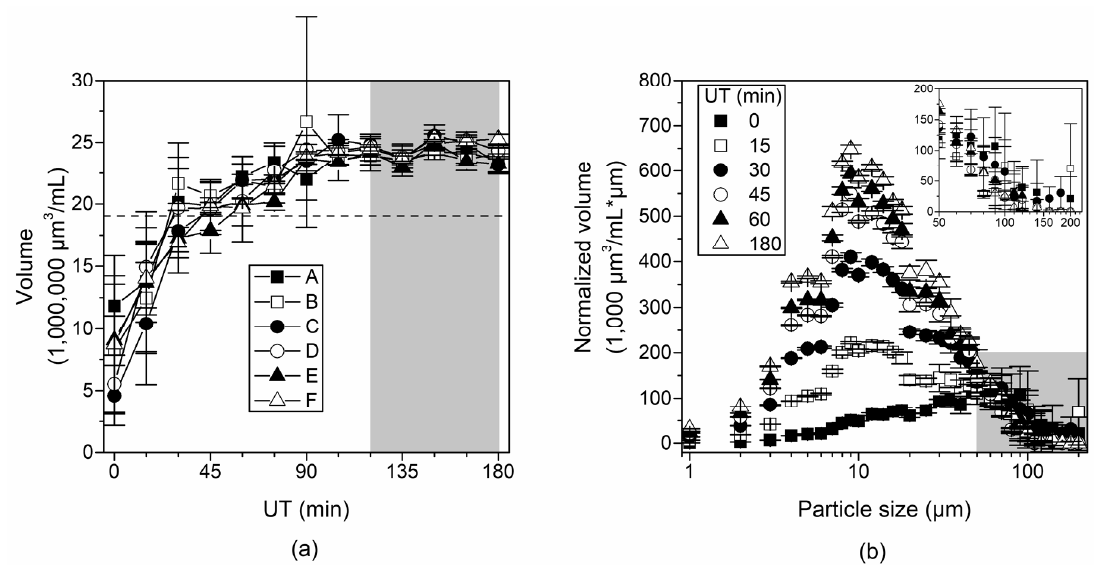
Figure 5. ( a ) Calculated suspended solid volume of six batches (A–F = 20 mg / L PS particles) during ultrasonic treatment (UT). Dotted line at 19,048,000 µ m 3 / mL indicates an E D of 100%. Highlighted area was used for calculation of mean volume and E D . ( b ) Calculated volume per size channel of batch A during 180 min of ultrasonic treatment. Values were normalized through division by channel width to compare smaller and larger channels. A non-normalized graph can be found in the SI, Figure S2. Error bars show standard deviation of n =